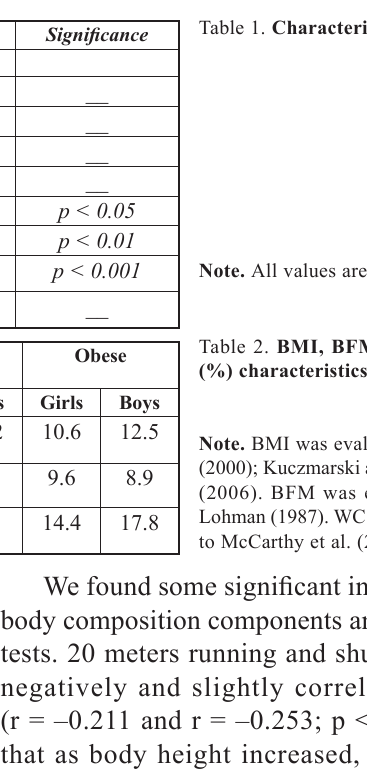
negatively and slightly correlated with height